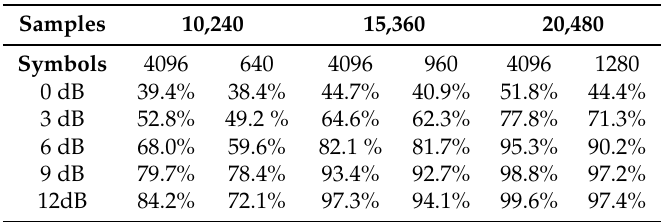
Table 2. Comparison for Ω 1 between compressive sensing (CS) method and classical method with equivalent number of